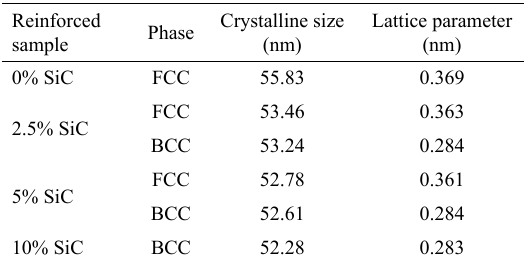
addition of SiCnp promotes the formation of a BCC phase since the lower content (2.5 wt.%). Lattice parameter and crystallite size information of sintered composites samples are reported in Table 1. The crystallite size refinement and